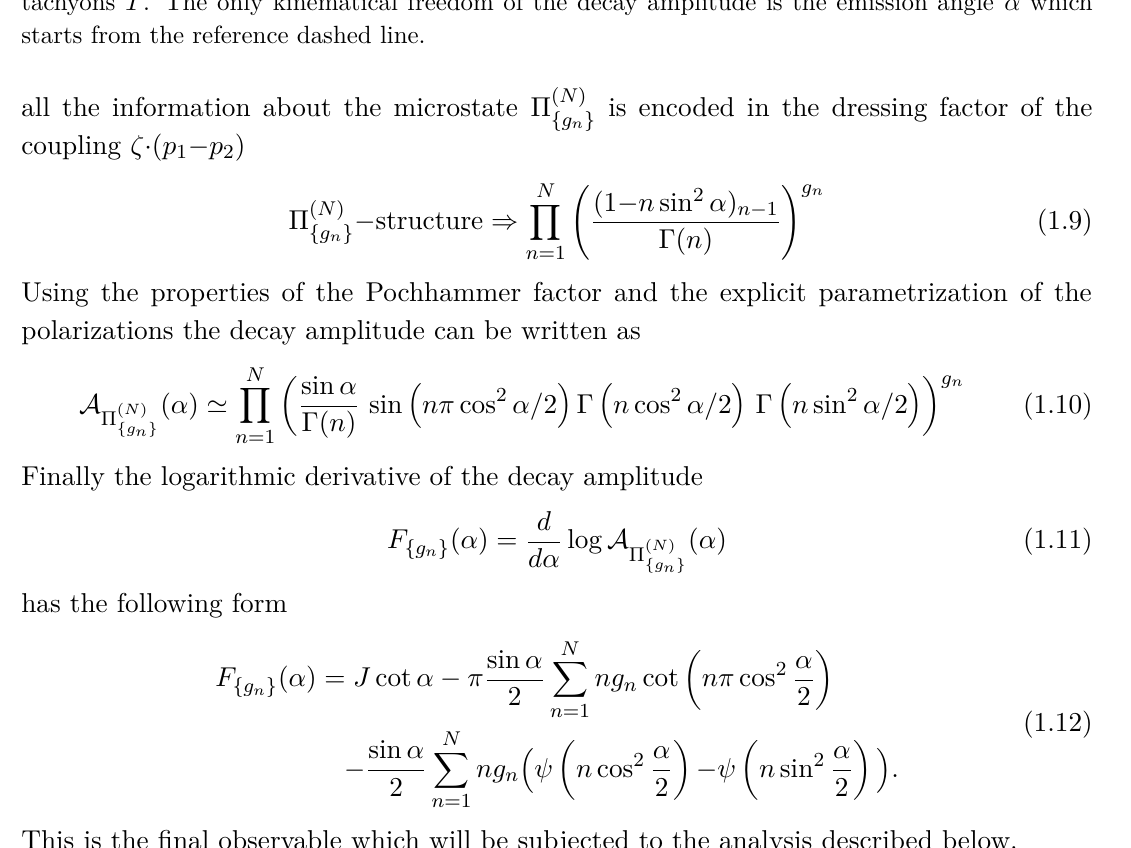
decays into two { g n }